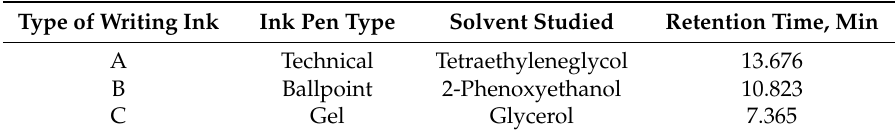
Table 7. Comparison of heating time at different temperatures and storage time under natural conditions with chromatographic parameters obtained for writing inks of different types.